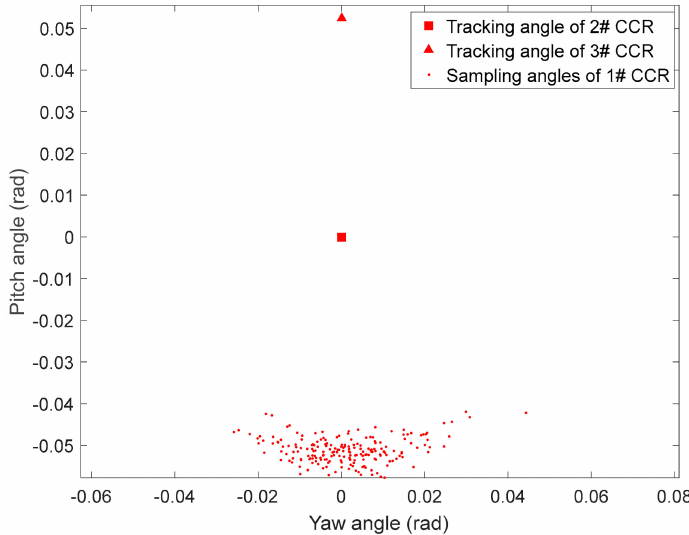
Figure 14. Recovery sampling angles after losing 1#